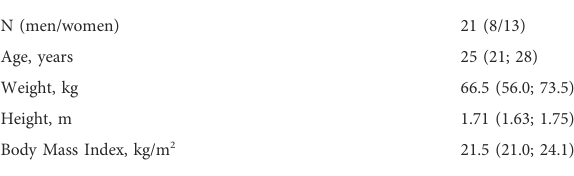
TABLE 1 Participant